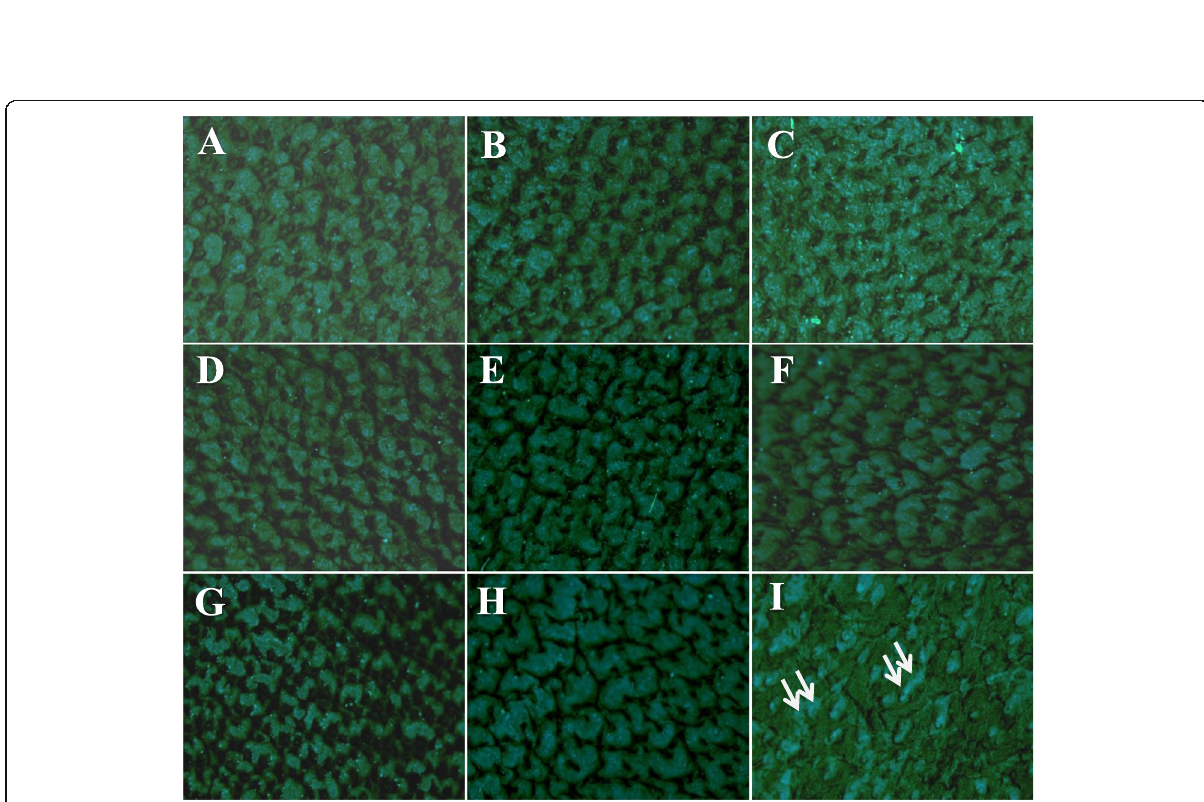
Fig. 6 The stereo-microscope profiles of the crust after unhairing ( a Cu(II); b Al(III); c Fe(III); d adipate; e salicylate; f laurate; g Gallate; h ECG; i Proteinase